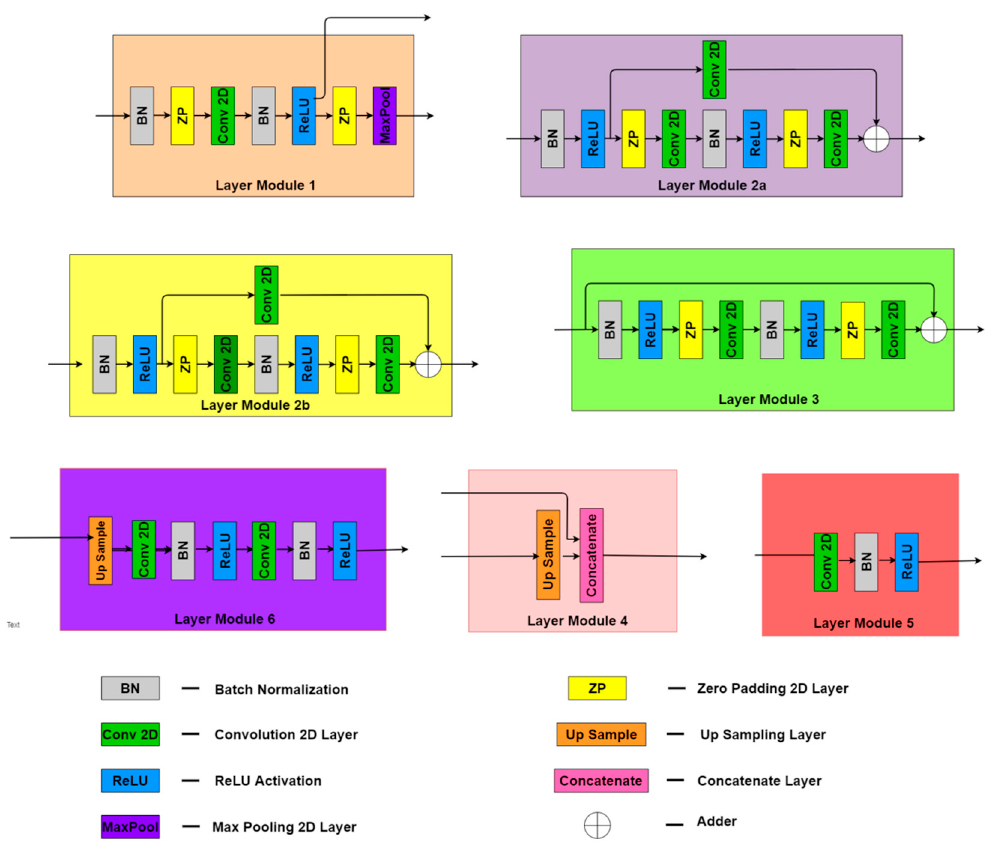
Figure 3. Layer details of the layer modules of UNBCSM.